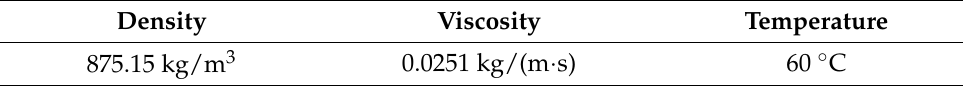
Table 3. The properties of oil.